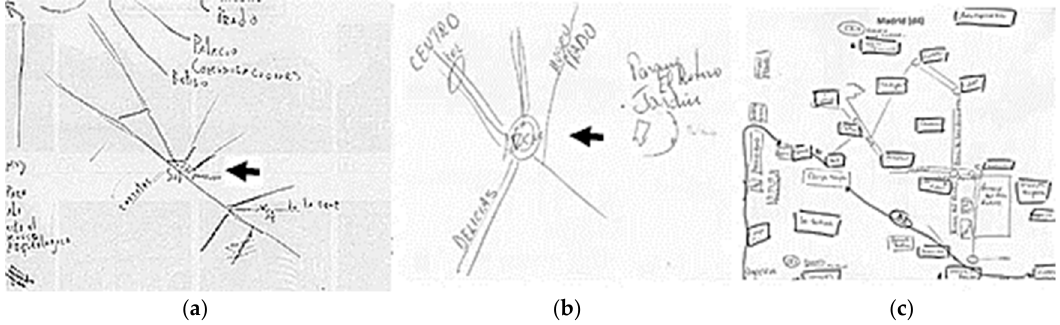
Figure 6. Different anchor points in the sketches: ( a ) POI close to the tourist’s accommodation; ( b ) the most-used public transport stop; ( c ) no anchor point.